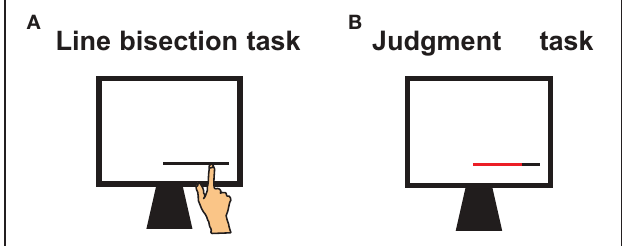
FIGURE 1 | Tasks and procedure. (A) Participants first performed a line bisection task in which they pointed to the lines’ midpoint with their index finger. (B) Participants then judged their own bisection errors. Each line, divided into two colored segments at the locations where the participant previously placed the bisection mark, was then re-presented. Participants had to name the color of the longer line